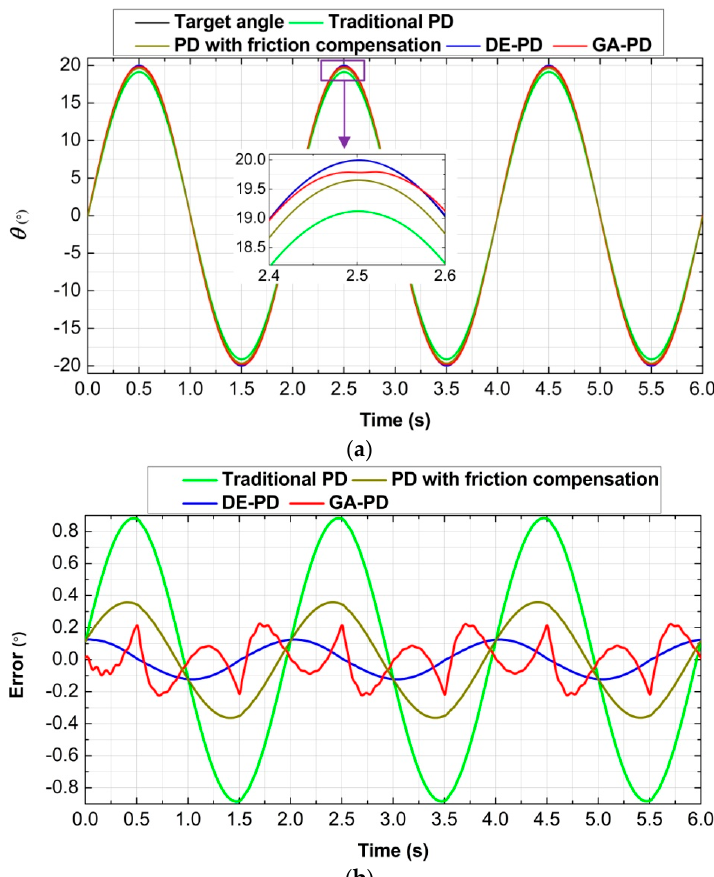
Figure 15. Position tracking performance in the stability experiment. ( a ) Angle contrast curve; ( b ) error contrast curve.